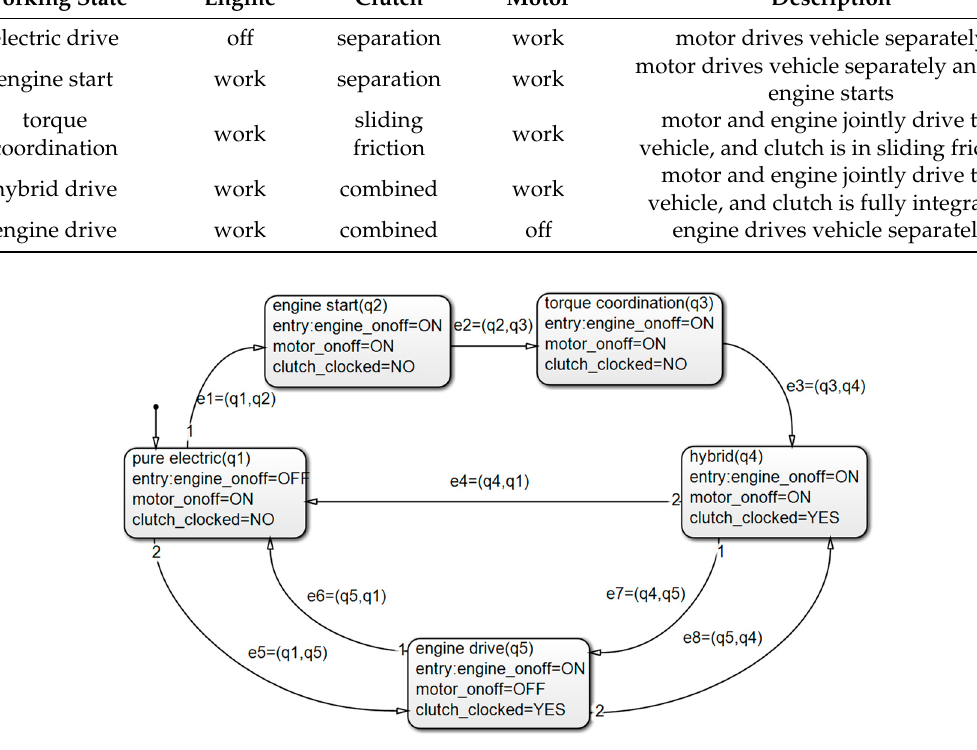
Figure 1. Working mode switching of hybrid power system.